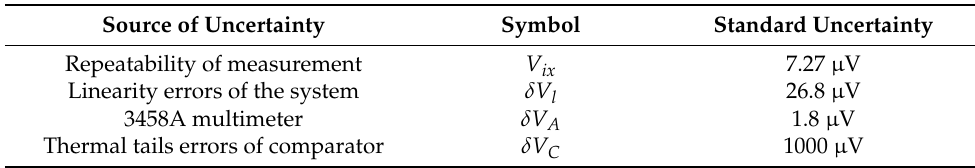
Table 3. Summary table of uncertainty components. Source of Uncertainty Symbol Standard Uncertainty Repeatability of measurement Linearity errors of the system Thermal tails errors of comparator δ V C 1000 µ